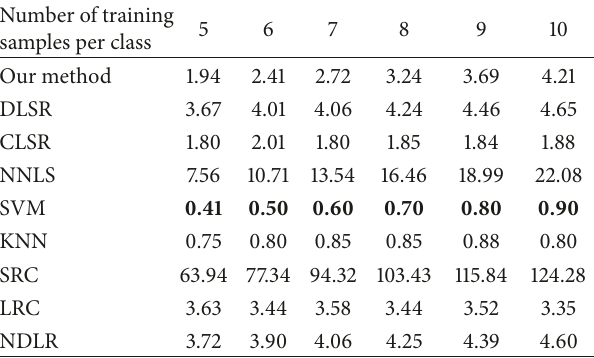
Table 7: Computing time (s) of different methods on the GT database.